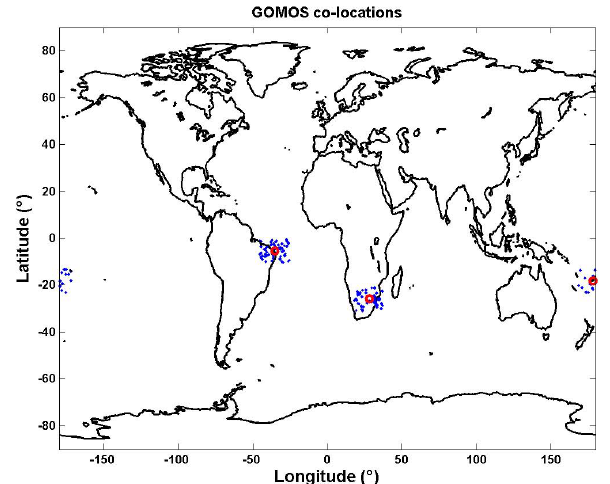
Fig. 7. Geographical locations of the GOMOS dark occultations (blue dots) compared with measurements from 3 stations: Natal, Fiji, Irene (red circles). Overpasses of GOMOS are measured within ± 12h time difference and spatial differences within ± 5 ◦ lat- itude and ± 10 ◦ longitude.